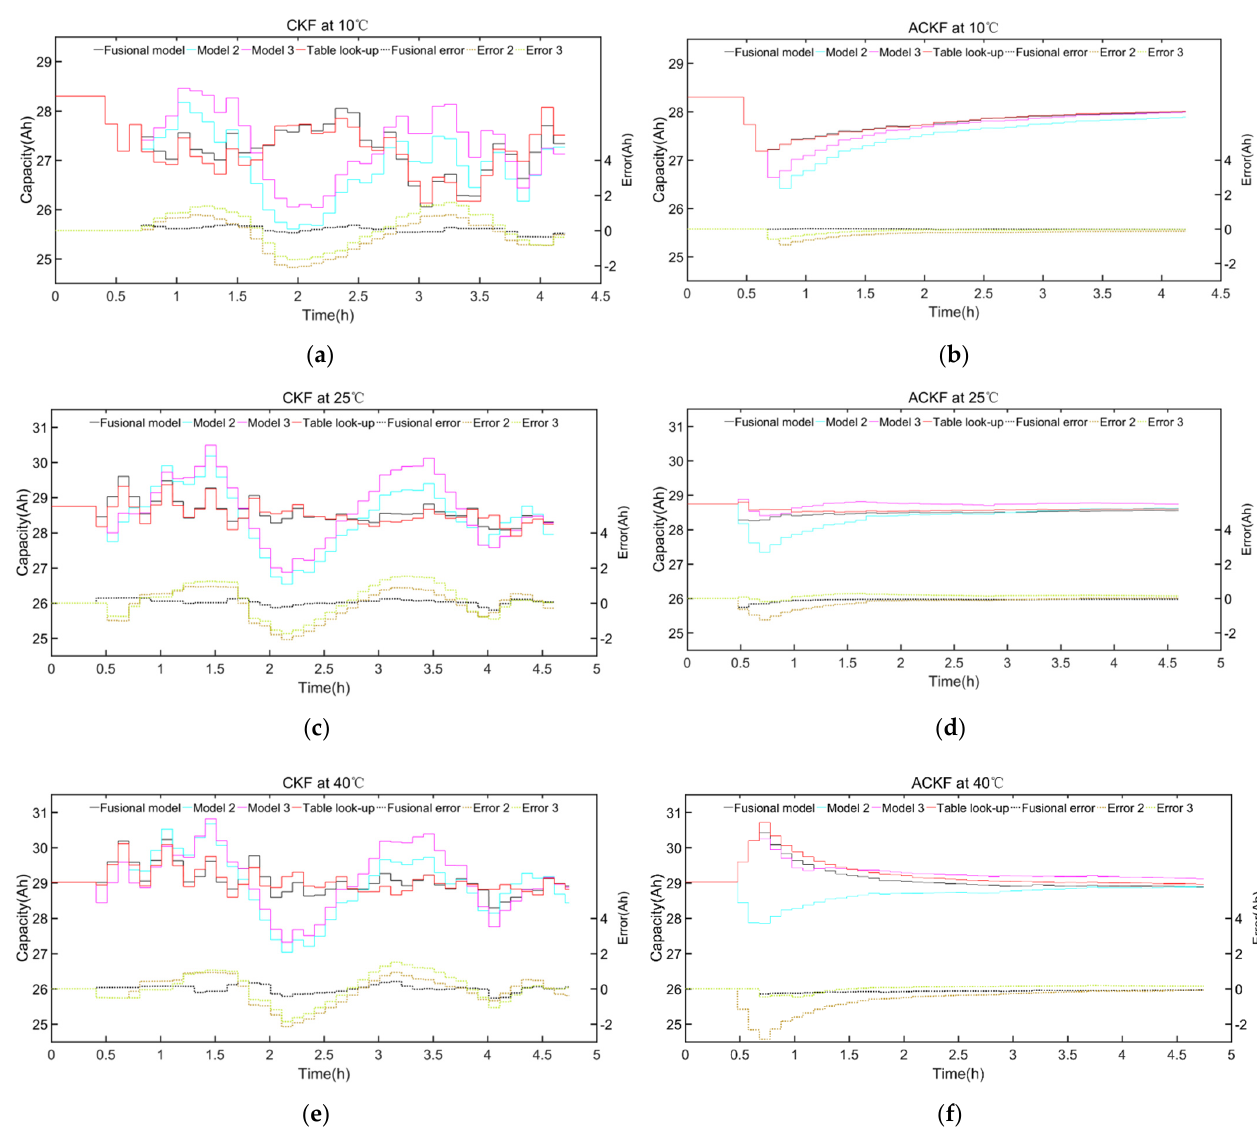
Figure 13. Capacity estimation results for NMC battery by using: ( a ) CKF at 10 °C. ( b ) ACKF at 10 °C. ( c ) CKF at 25 °C. ( d ) ACKF at 25 °C. ( e ) CKF at 40 °C. ( f ) ACKF at 40 °C.